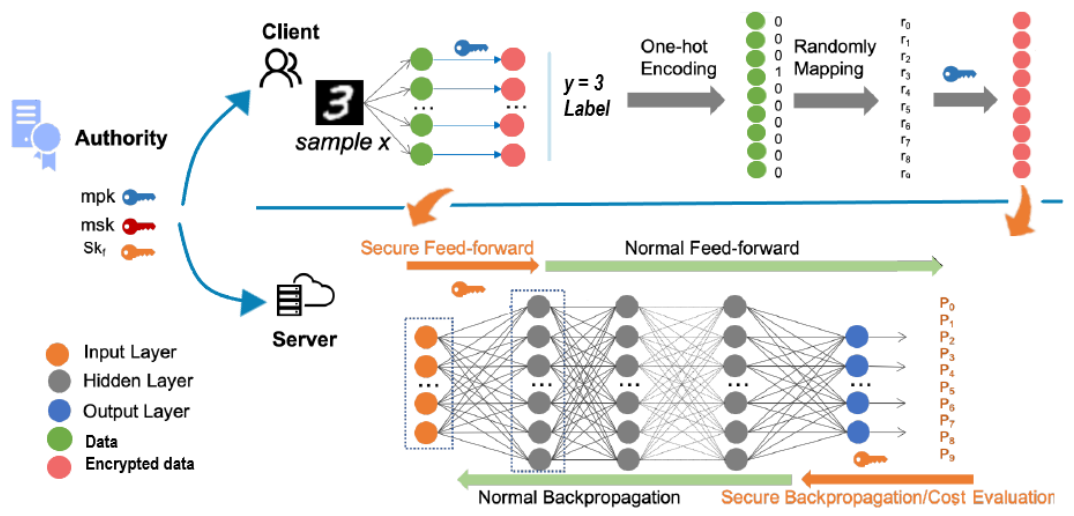
Figure 1. CryptoNN framework, reproduced from